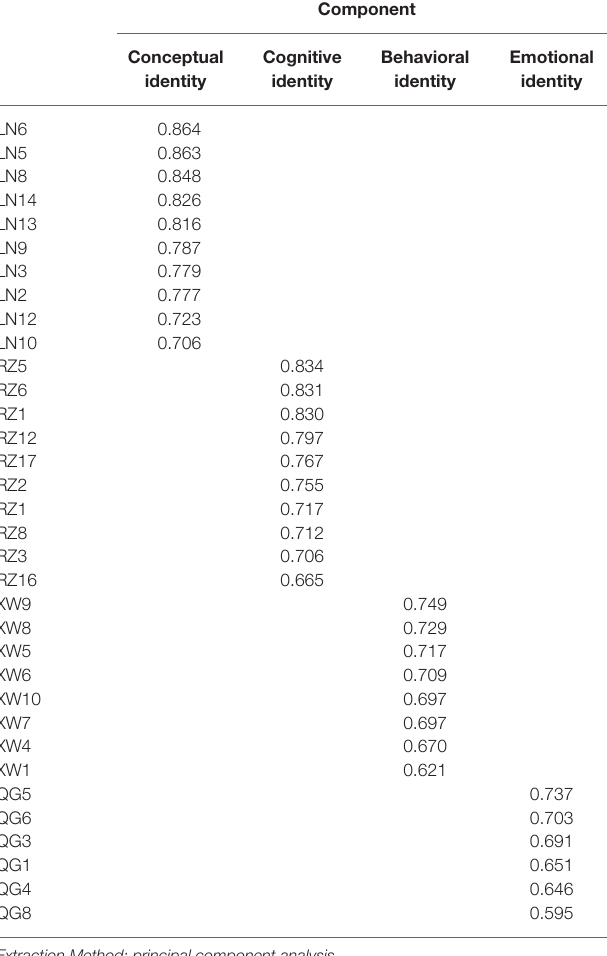
TABLE 3 | Rotated component matrix.